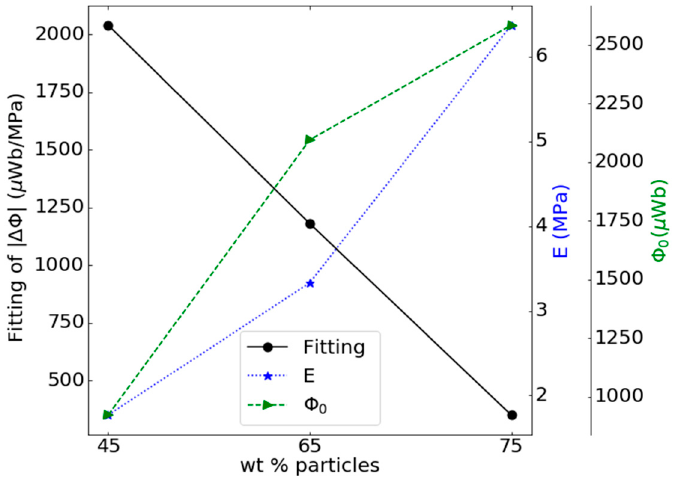
Figure 9. Slope of the fitting of the Villari signal, Young’s modulus and initial magnetic flux of the composites in function of the reinforcement content for the fifth step of the procedure.